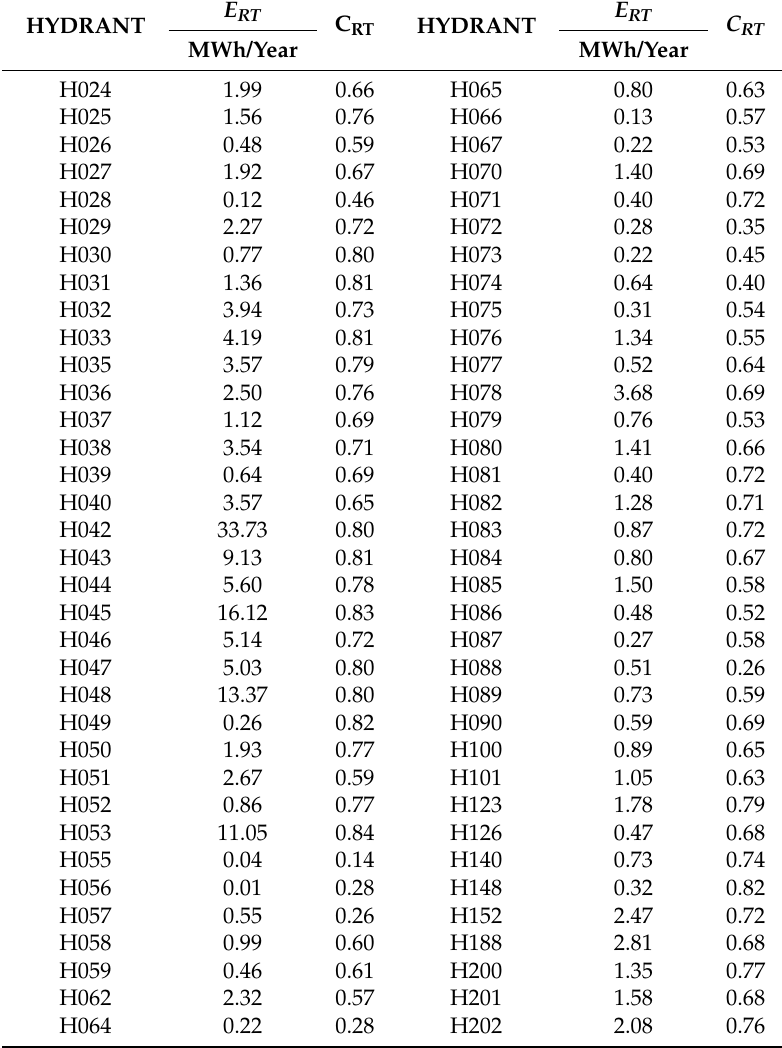
Table 1. Theoretical energy recoverable in hydrants on the irrigation network.